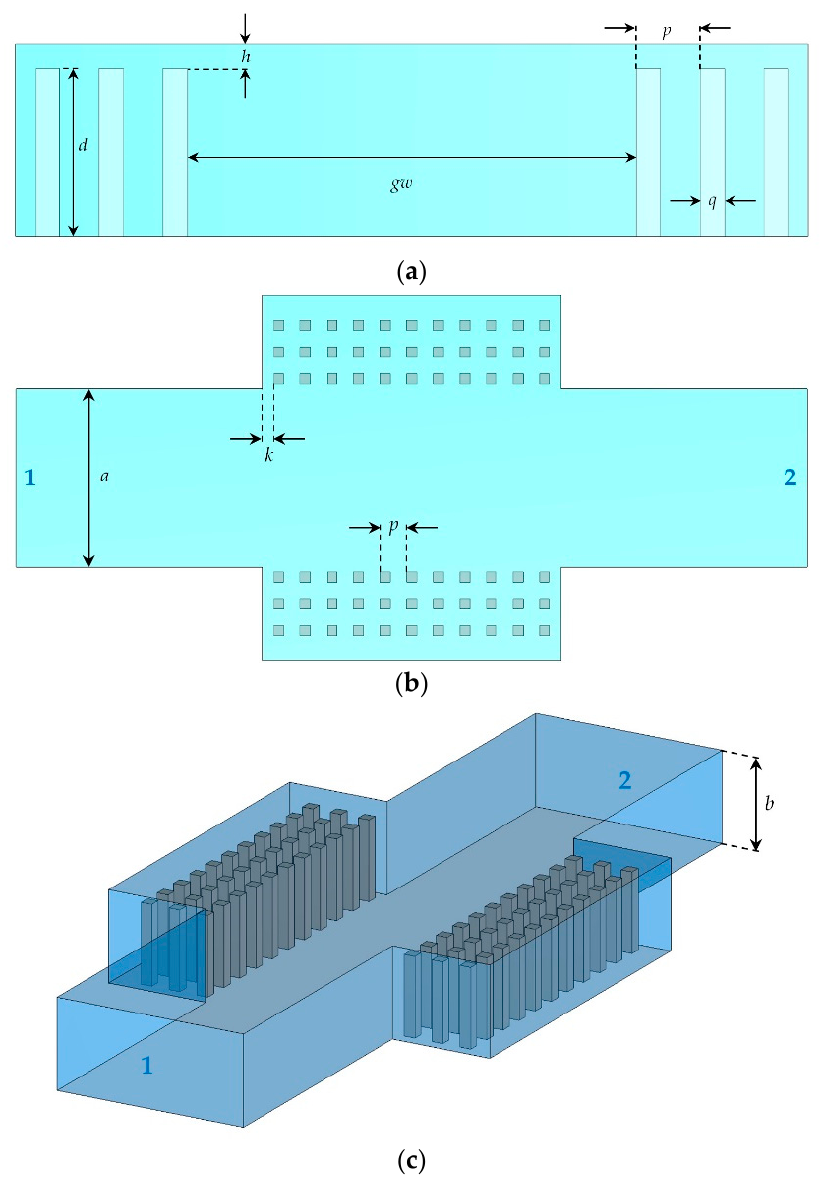
Figure 1. Groove gap waveguide geometry. ( a ) Cross section. ( b ) Top view. ( c ) 3D view. The propagation constant of the equivalent RW is also plotted in Figure 2, indicating a strong similarity between the fundamental modes of the two waveguides in the designated bandwidth. Figure 4 clearly shows that the electric field is almost nonexistent after the third row of pins, as expected. The GGW geometrical parameters are listed in Table